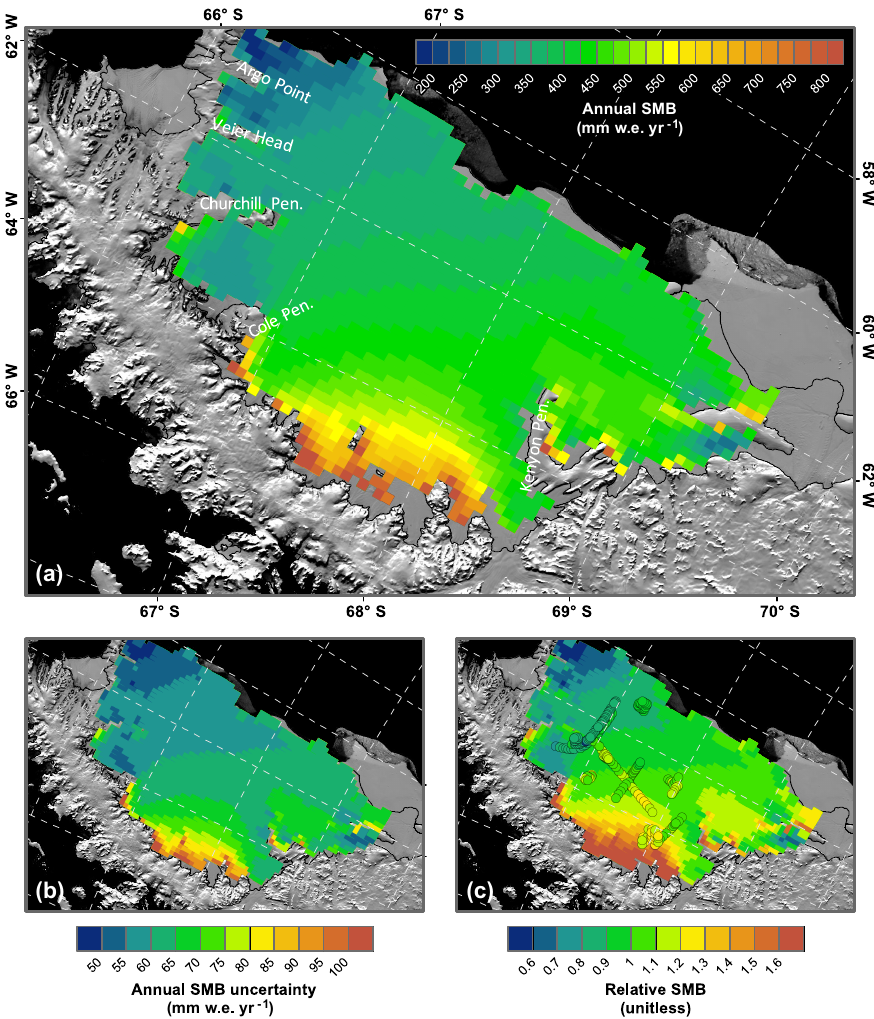
Figure 10. (a) Map of the Larsen C ice shelf showing a reconstruction of annual SMB (in mm w.e.year − 1 ), obtained by adjusting 1979– 2014 RACMO2 SMB to the spatial pattern of ground-penetrating radar and observations of SMB from sonic height rangers. (b) Estimated uncertainty of the SMB values in panel (a) (in mmw.e.year − 1 ). (c) Coloured dots indicate depth of the reflection horizon, detected by GPR, normalized with respect to the mean depth (unitless). The background shows a map of relative SMB (unitless) from